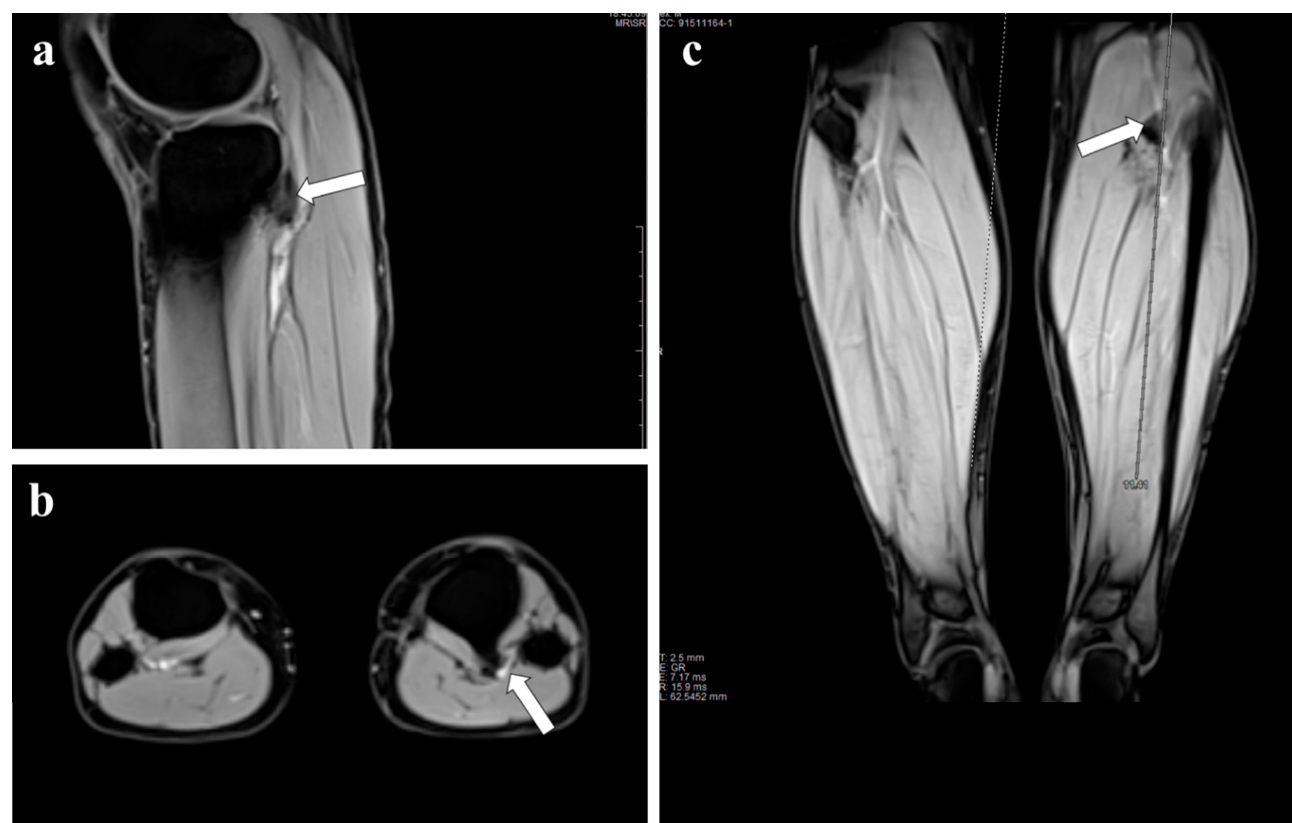
Figure 2. Magnetic resonance ( a ) sagittal, ( b ) axial and ( c ) coronal STIR images show the marrow and cortical continuity of the pedunculated osteochondroma and underlying tibia, and with a relatively thin cartilage cup (white arrows).